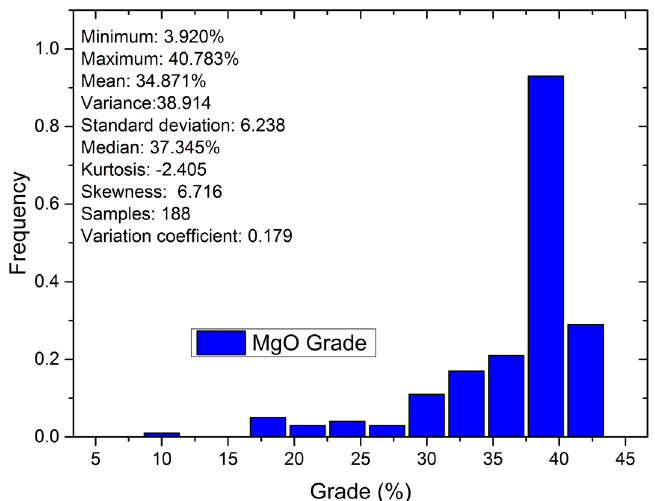
Figure 4. Grade distribution of MgO